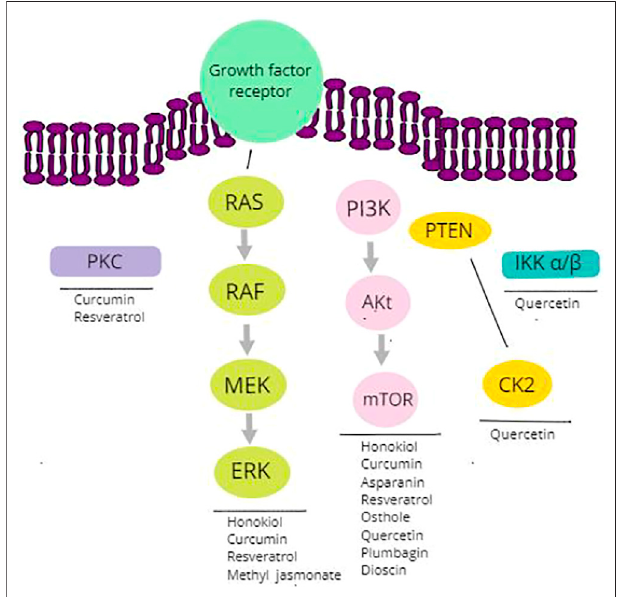
FIGURE2| Intracellularsignalingpathway,includingproteinkinasesand natural